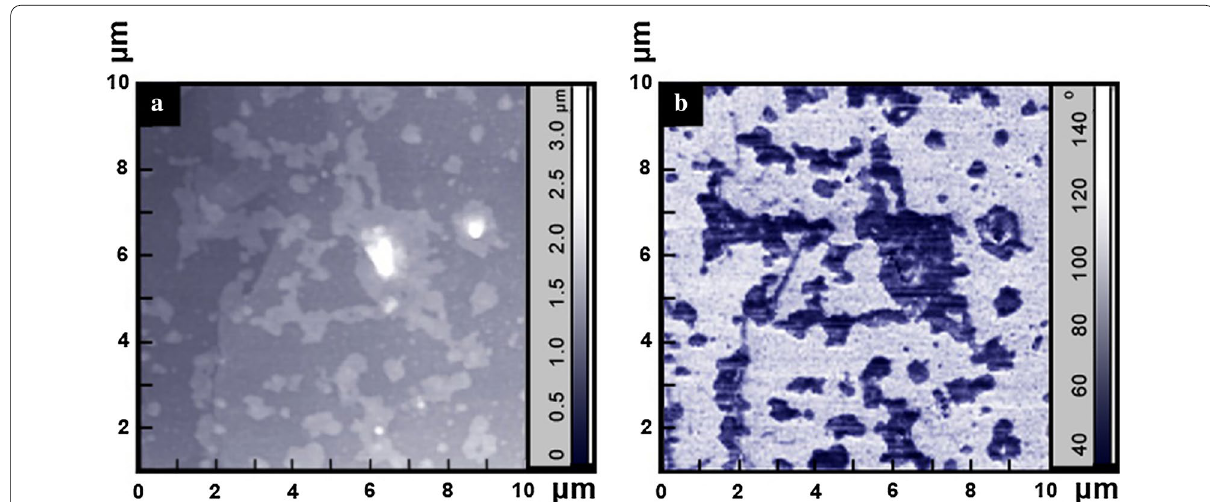
Fig. 6 a AFM image of the BDD obtained in surface-relief height scanning mode. b Phase contrast image in tapping-mode AFM of the same BDD